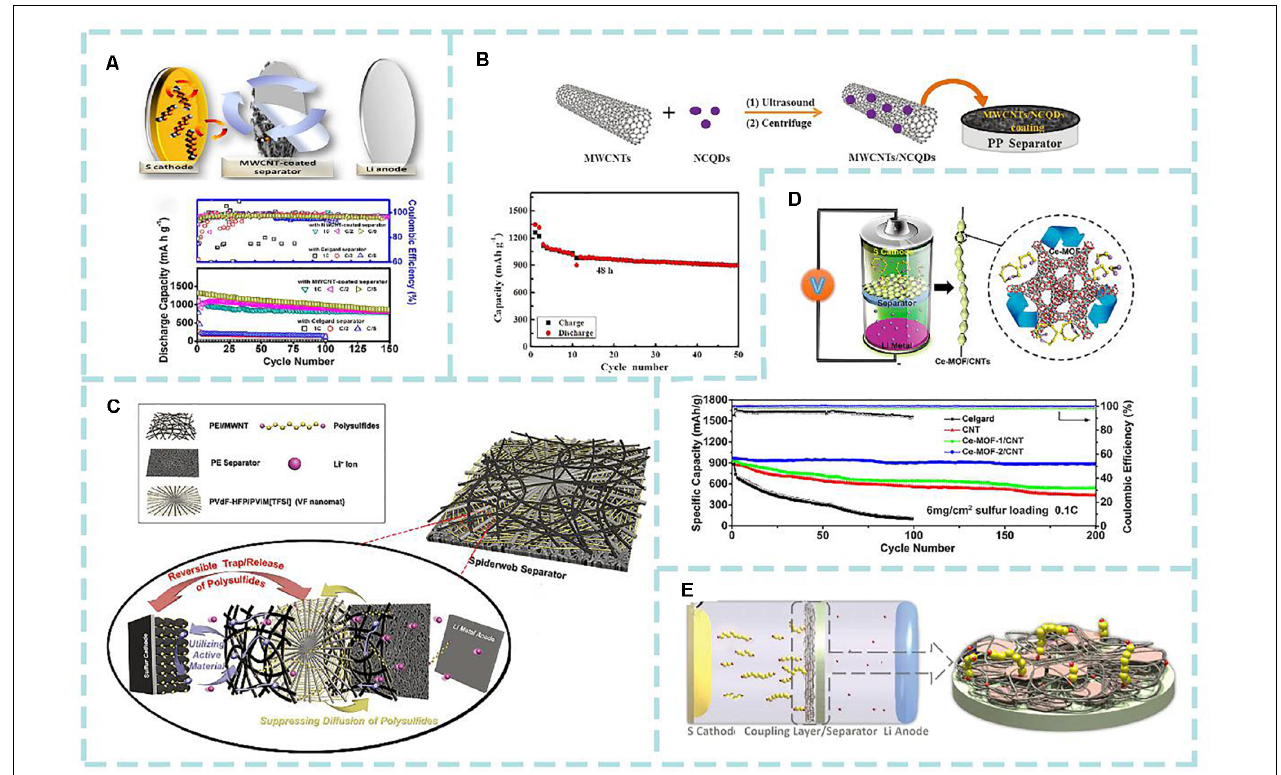
FIGURE 1 | (A) Mechanism of multi-walled carbon nanotubes (MWCNTs)-coated separator for Li–S batteries and the corresponding cycling performance; (B) Schematic diagram of MWCNTs/N-doped carbon quantum dots (MWCNTs/NCQDs)-coated separator preparation process and the cycle performance of the Li–S battery with MWCNTs/NCQDs-coated separator; (C) Schematic illustration of spiderweb separator and its application in Li–S batteries; (D) Scheme of Ce-MOFs/CNTs as coating materials in Li–S battery and the corresponding cyclic performance; (E) Schematic configuration of the Li–S cell with a Sb 2 S 3 /CNTs coated membrane. (A) Reproduced with permission. Chung and Manthiram (2014) Copyright 2014, American Chemical Society. (B) Reproduced with permission. Pang et al. (2018) Copyright 2018, Wiley-VCH. (C) Reproduced with permission. Lee Y.-H. et al. (2018) Copyright 2018, Wiley-VCH. (D) Reproduced with permission. Hong et al. (2019) Copyright 2019, American Chemical Society. (E) Reproduced with permission. Yao S. et al. (2018) Copyright 2018,